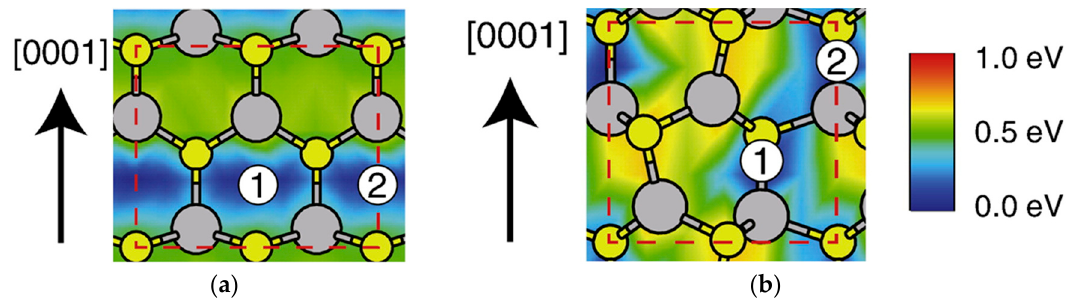
Figure 29. Adsorption sites and migration barriers for an In atom on ( a ) ( 1100 ) and ( b ) ( 1120 ) surfaces. Encircled numbers and contour plots represent adsorption sites and migration barriers, respectively. Large gray and small yellow circles represent In and P atoms, respectively. Reprinted with permission from [99]. Copyright (2013) by Elsevier.